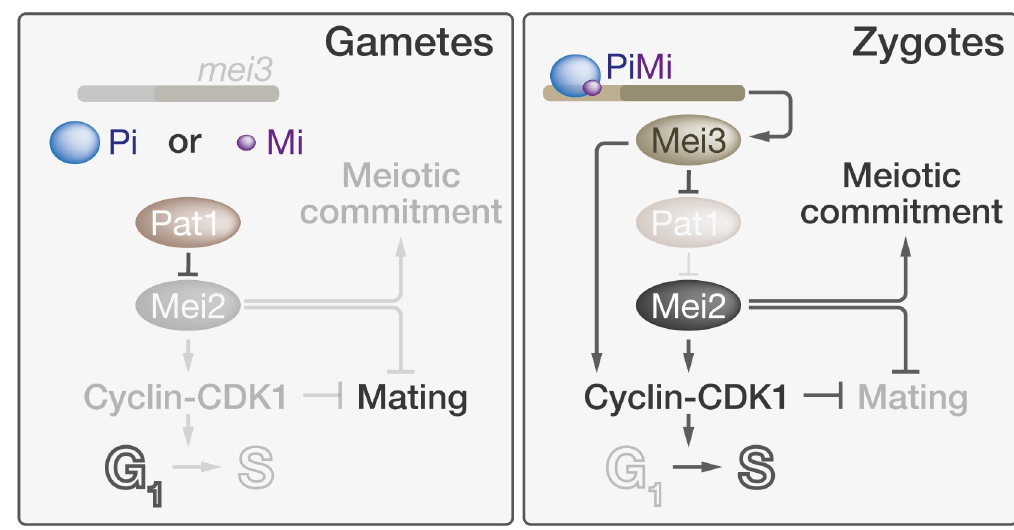
Fig 8. Model for gamete to zygote transition in fission yeast. In G1-arrested gametes (left panel), which express either Pi or Mi, mei3 is not expressed and Pat1 maintains Mei2 repression to prevent meiosis and allow mating. Postfertilization (right panel), the Pi–Mi complex induces Mei3 expression which relieves Mei2 inhibition. Mei3 and Mei2 independently activate CDK1 to repress mating and drive the G1 exit. Additionally, Mei2 commits zygotes to meiosis and imposes a second, cell cycle-independent block to